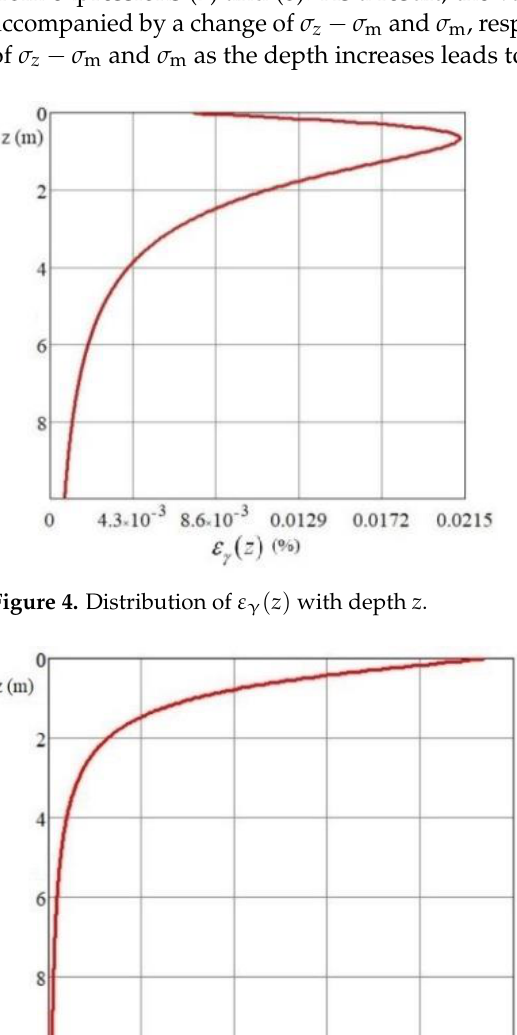
 with depth z . Figure 5. Distribution of ε v ( z ) with depth z v  with depth z . v